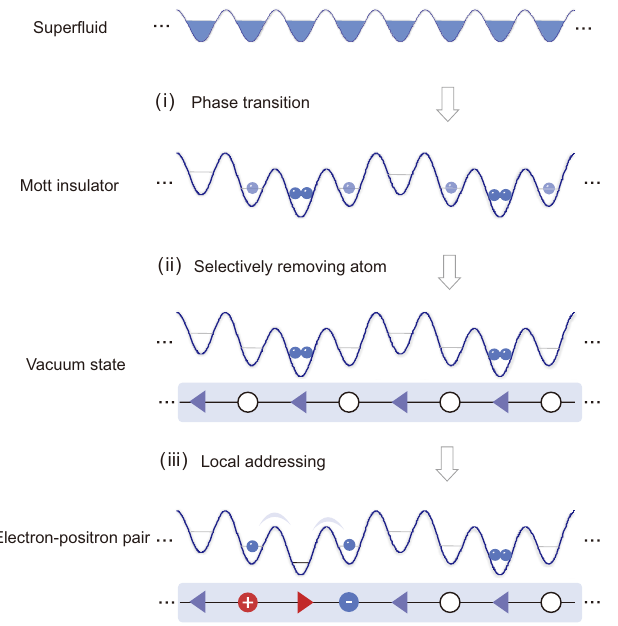
FIG. 2. Proposed experimental protocol for state initialization. A single-species Bose-Einstein condensate is confined in one spatial dimension. An optical superlattice is ramped up to drive a phase transition from a superfluid to a Mott insulator in small wedding-cake-like structures. After selectively removing atoms from every second well, the system is initialized in the “vacuum state” represented by | . . . , 0, 0, 2, 0, . . . (cid:7) . In scenarios where one is interested in the state with one electron-positron excitation in the vacuum, as | . . . 0, 2, 0, 0, 1, 0, 1, 0, 0, 2, 0, . . . (cid:7) , local address- ing can selectively lower the potential barriers near one doublon in order to allow for tunneling of the atoms to the matter